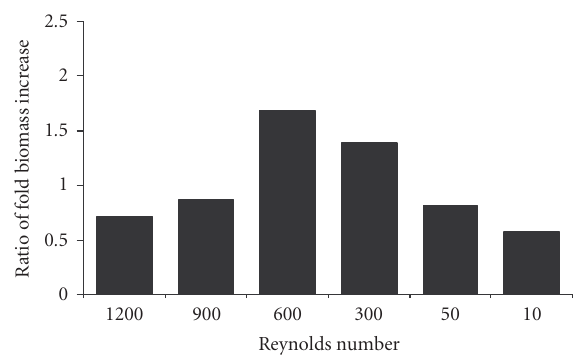
Figure 6: E ff ect of stirring rate on cell growth in bioreactors. Graph of the biomass increase of EL-4 cell colonies after culture in stirred rotating bioreactors at a range of rotational speeds, compared to no rotation.